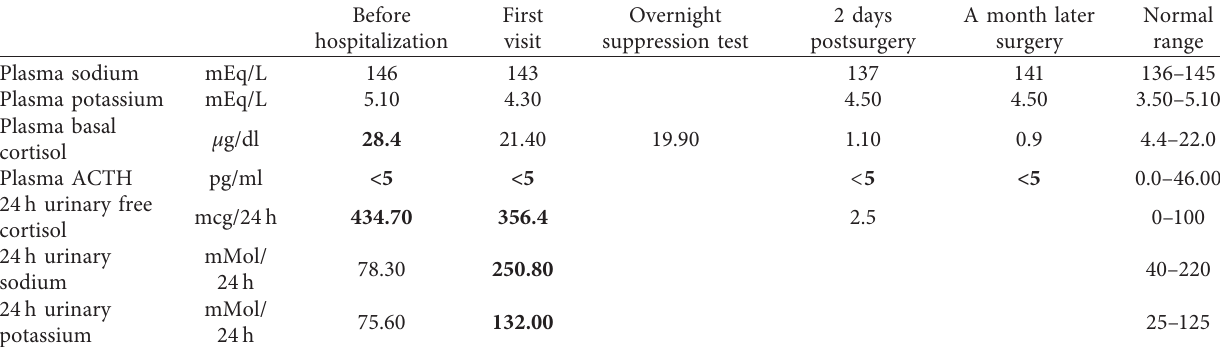
Table 1: Laboratory tests.